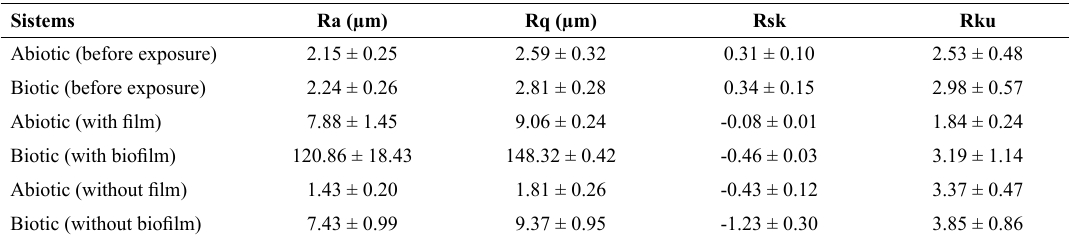
Table 3. Analysis of surface roughness of API 5L X80 steel coupons.